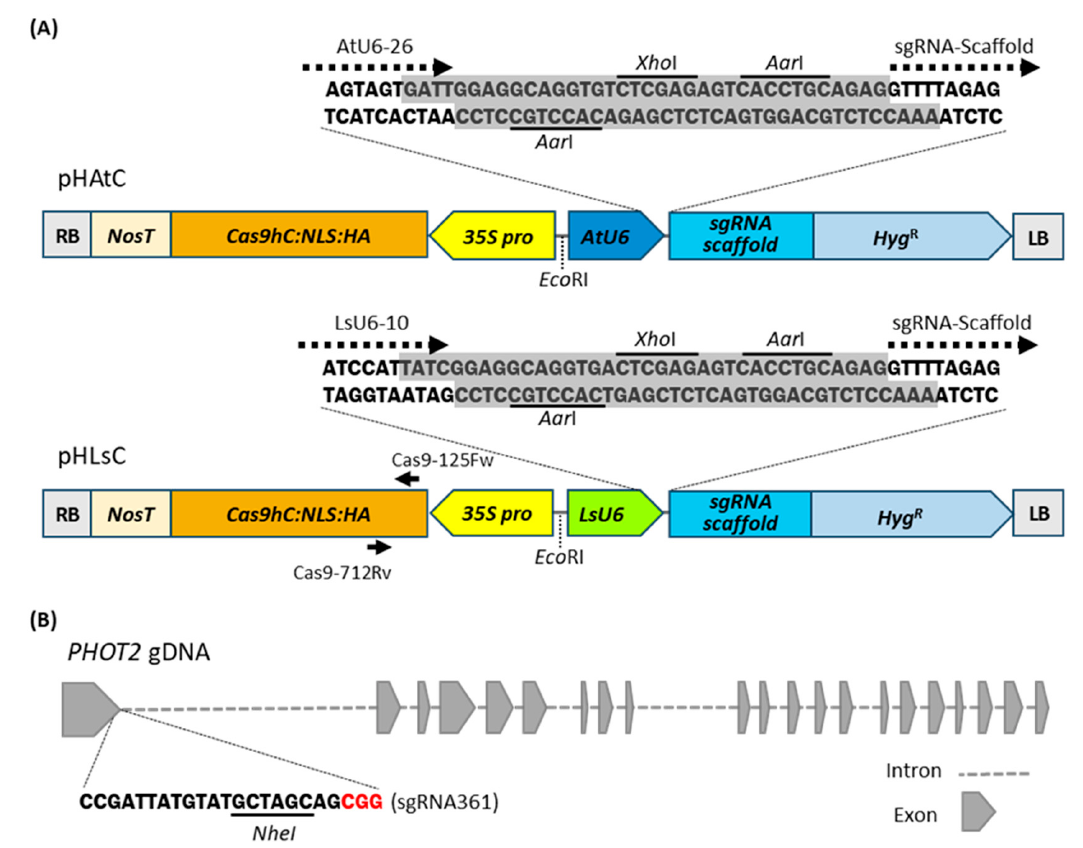
Figure 2. Schematic diagrams of CRISPR/Cas9 expression vectors and sgRNA targeting site in PHOT2 gene. ( A ) Schematic diagrams of CRISPR/Cas9 expression vectors used for Agrobacterium - mediated lettuce transformation. In pHAtC, a single guide RNA (sgRNA) cassette is driven by the Arabidopsis U6-26 promoter (AtU6), and in pHLsC, the sgRNA cassette is driven by the Lactuca sativa U6-10 promoter (LsU6). Cas9-125Fw and Cas9-712Rv indicate a primer set used to confirm transgene integrations. NosT, nopaline synthase (NOS) terminator; Cas9hc:NLS:HA, human codon-optimized Cas9 expressing cassette; 35S pro, CaMV 35S promoter; Hyg R , Hygromycin resistance gene cassette; LB, left border; RB, right border. The Aar I recognition site (CACCTGC) and Xho I recognition site (CTCGAG) are underlined. ( B ) A schematic diagram of the sgRNA361 targeting site in the genomic region of PHOT2. The PAM motif (CGG) is shown in red; the Nhe I recognition site (GCTAGC) is underlined.